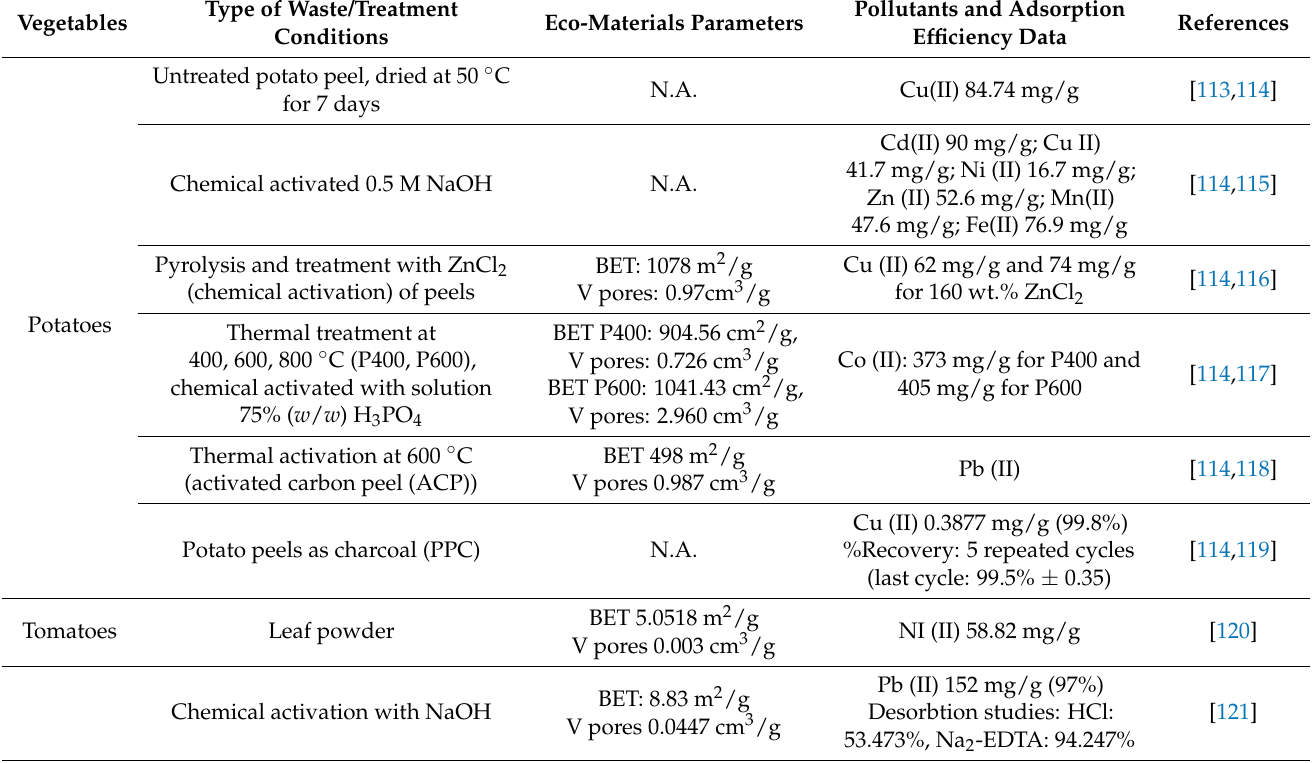
Table 2. Examples of uses of vegetable wastes as adsorbents for water